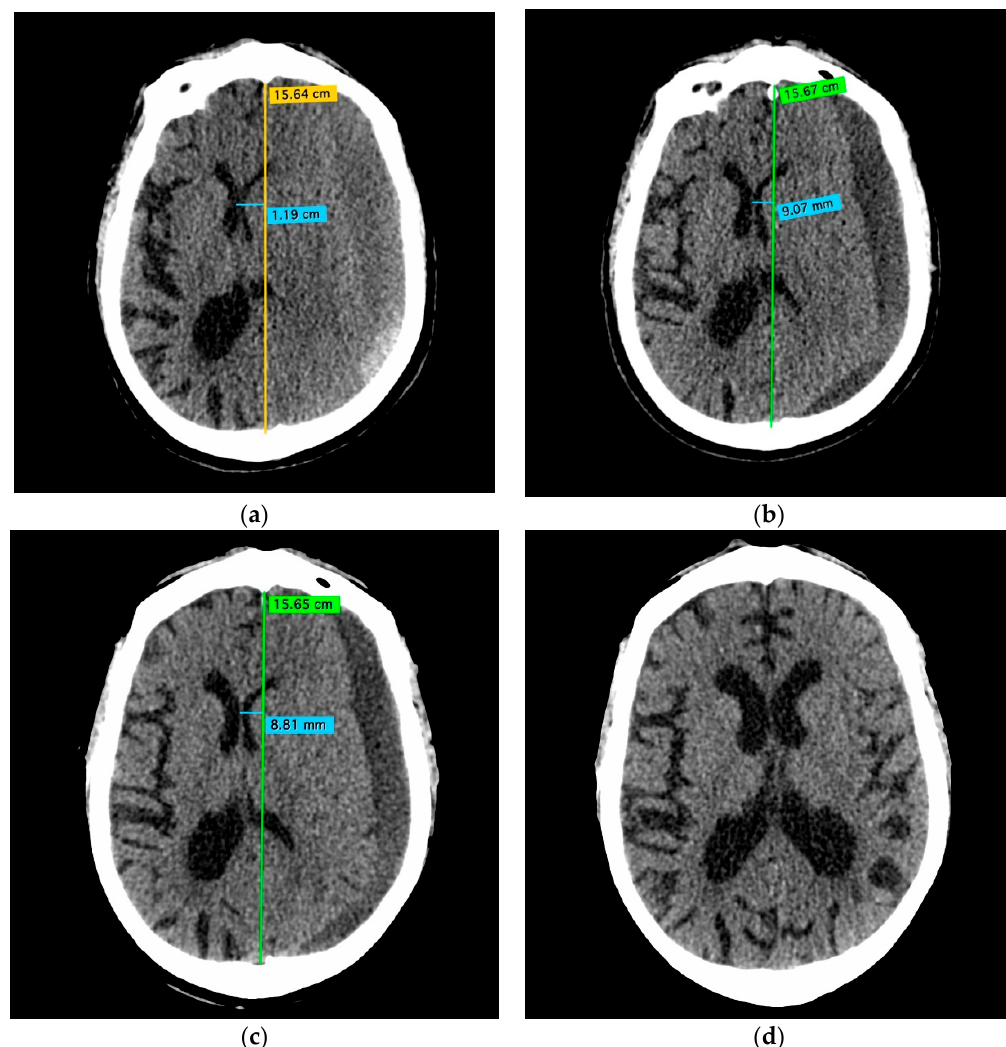
Figure 3. NCCT before ( a ), 5 days ( b ), 8 days ( c ), and 6 months ( d ) after the treatment of a left-sided CSDH with Squid embolization of the left MMA. The volume of the CSDH and the resulting midline shift were partially resolved within the first week after the embolization ( b ,c). Follow-up NCCT after 6 months ( d ) confirmed the complete resolution of the CSDH.